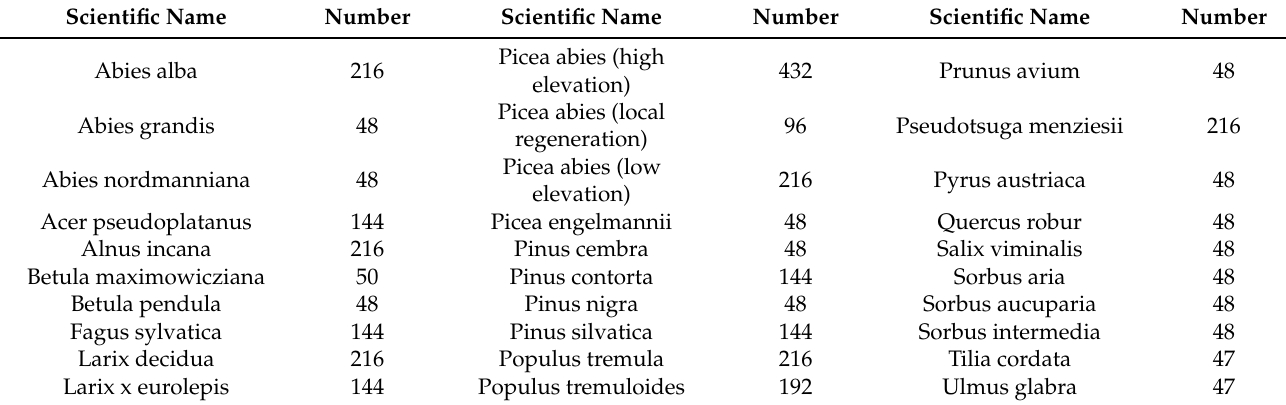
Table 3. Total number of tree seedlings that are used in the reforestation experiment at Wechsel.